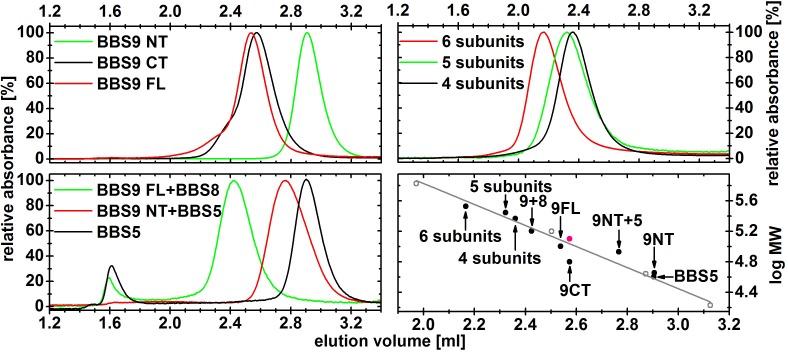
Normalized gel filtration profiles of different BBS complexes.The samples were purified by affinity chromatography and subsequent gel filtration, and 2.5–10 µg of the peak fraction was then analyzed on a Superdex 200 5/20 column. The complexes containing 4, 5 and 6 subunits are composed of BBS 4,8,9,18; BBS 1,5,8,9,18 and BBS 1,4,5,8,9,18, respectively. Their elution volumes were plotted against the theoretical molecular weight of the monomeric complex (black circles) and compared with standard proteins (open grey circles, and a grey line for the linear fit line). The elution volume of the C-terminal domain of BBS9 fits better to a dimeric species, which is shown as a red circle.